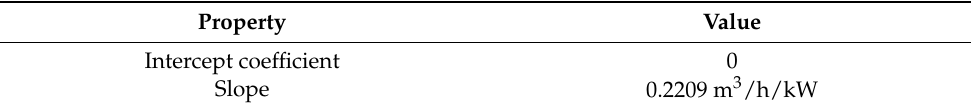
Table A9. DFC300 fuel cell fuel curve